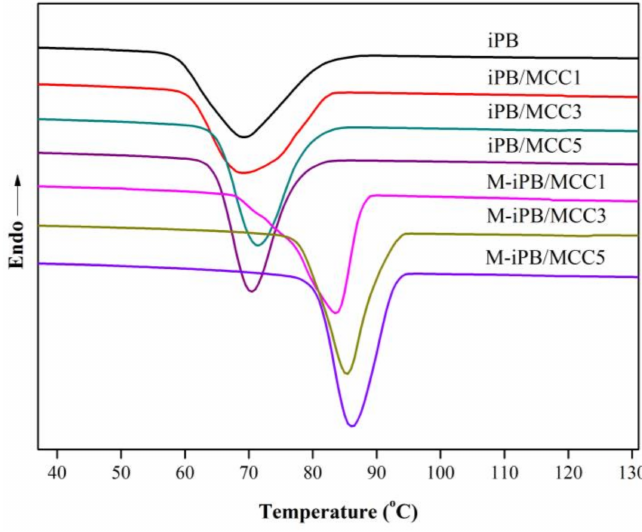
Figure 8. Non-isothermal crystallization DSC curve of iPB/MCC